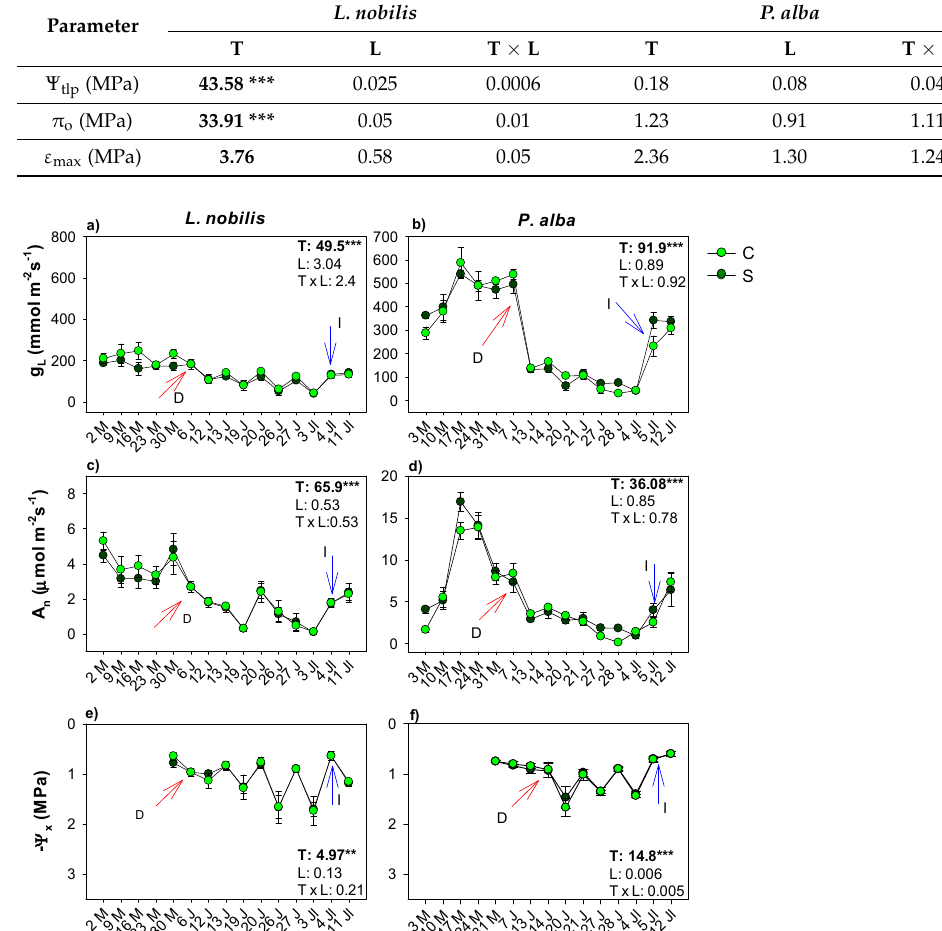
Table 4. Results of the two-way ANOVA analysis of parameters determined from PV-curves’ analysis by time of measurement, T (i.e., Before drought and at the end of experiment) and light treatment, L (i.e., control and shaded samples). Numbers represent F values; *** = p < 0.001. L. nobilis P. alba Parameter